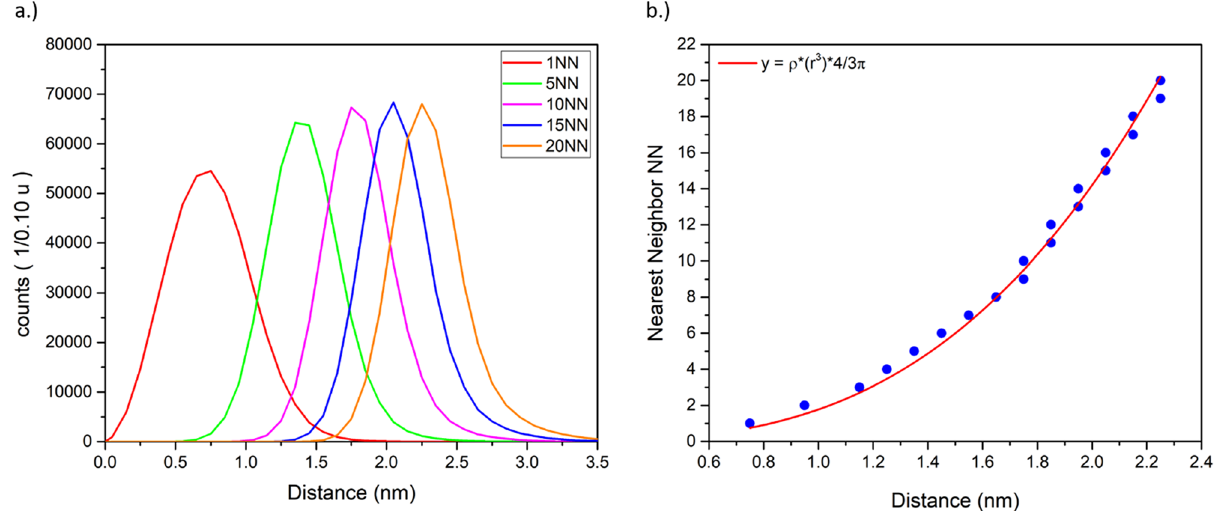
Figure 9. ( a ) Radius distribution to include the NN other glucose molecules around a glucose molecule. ( b ) Increase of the mean radius with number of nearest